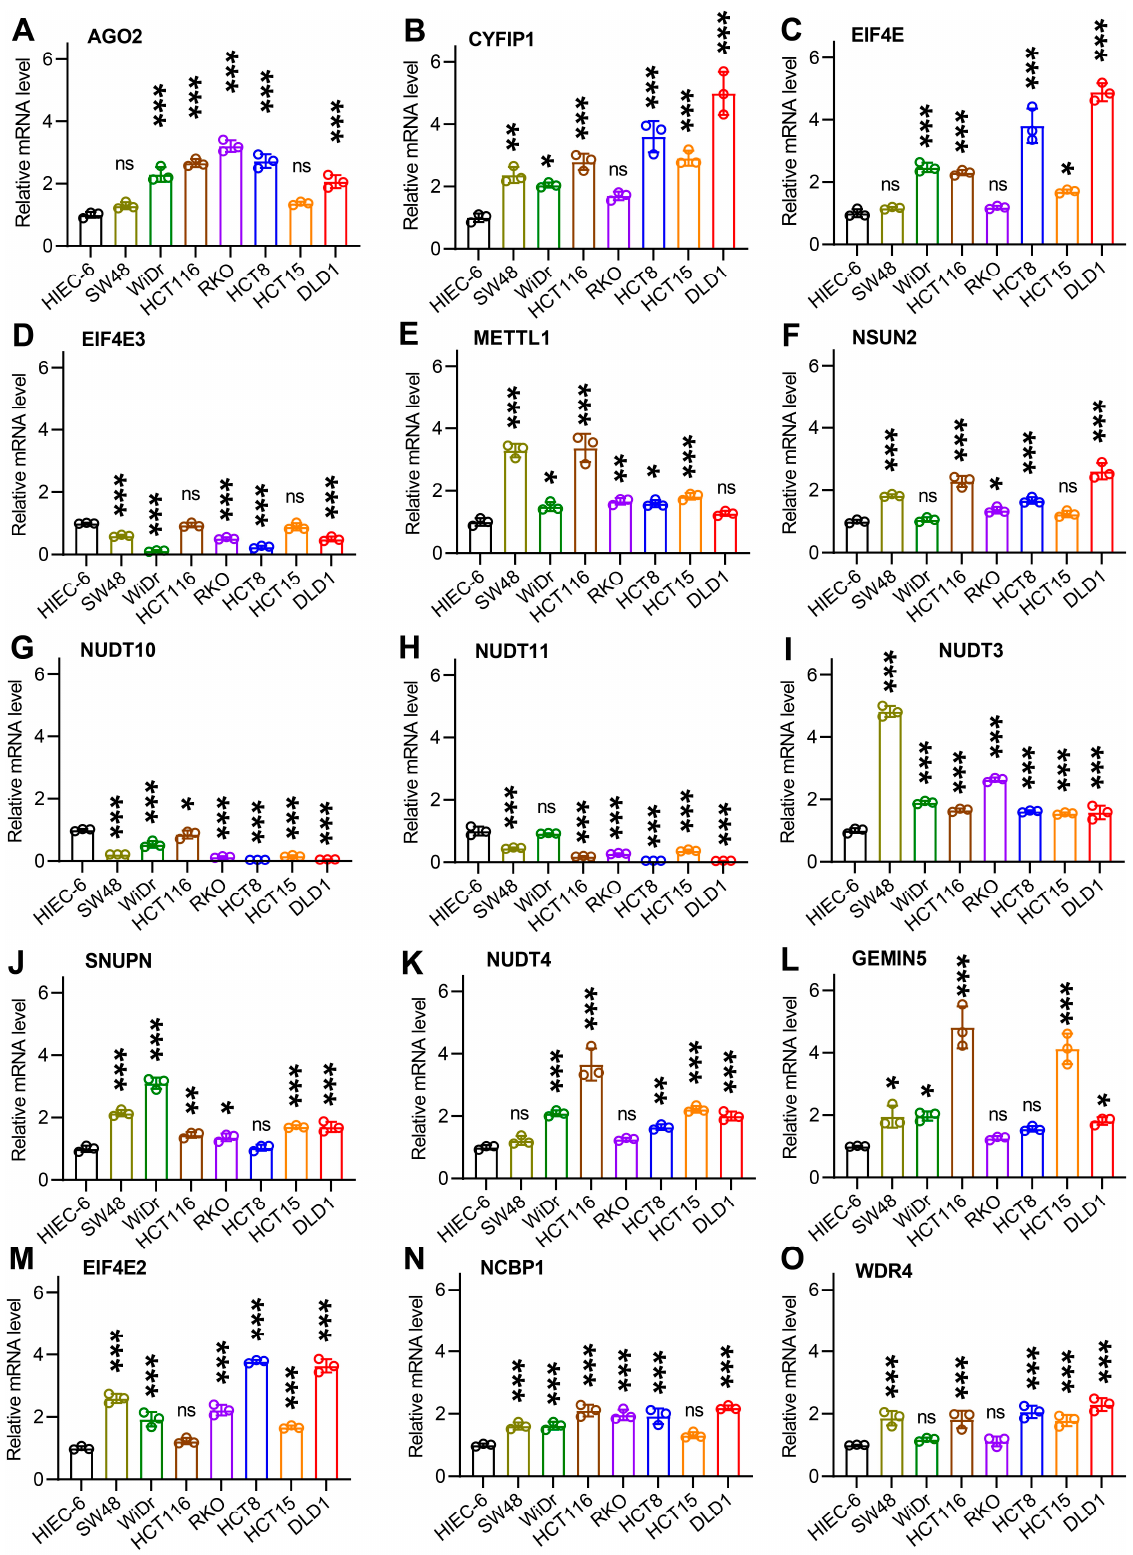
Figure 6. Validation for the expression level of 15 prognostic m7G-related genes in human CC cell lines. ( A – O ) Expression level of 15 prognosis-associated m7G genes in 7 human CC cell lines (RKO, HCT8, HCT116, SW48, WiDr, HCT15, and DLD1) and normal human intestinal epithelial cells (HIEC6). * p < 0.05, ** p < 0.01, *** p <